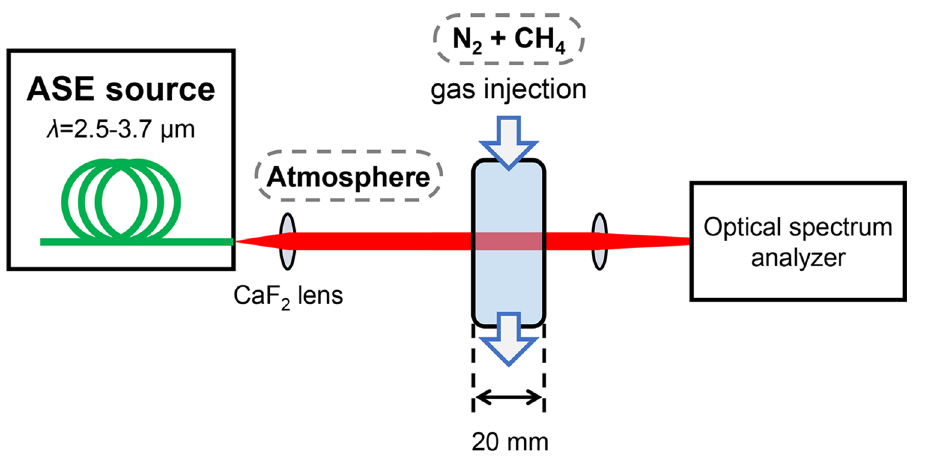
Figure 8. Experimental setup for CH 4 gas